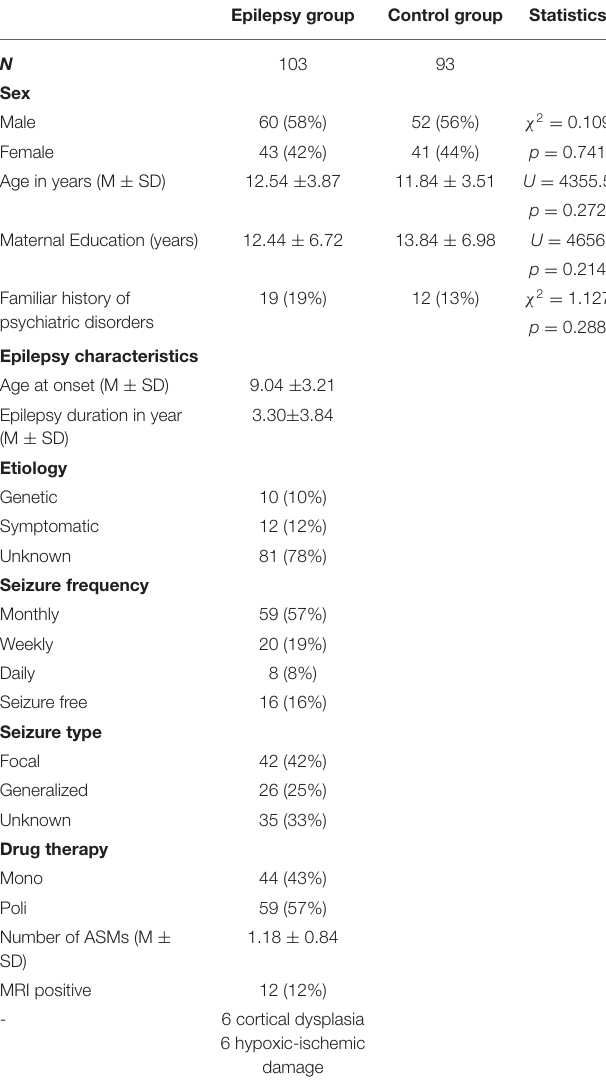
TABLE 1 | Demographic and clinical